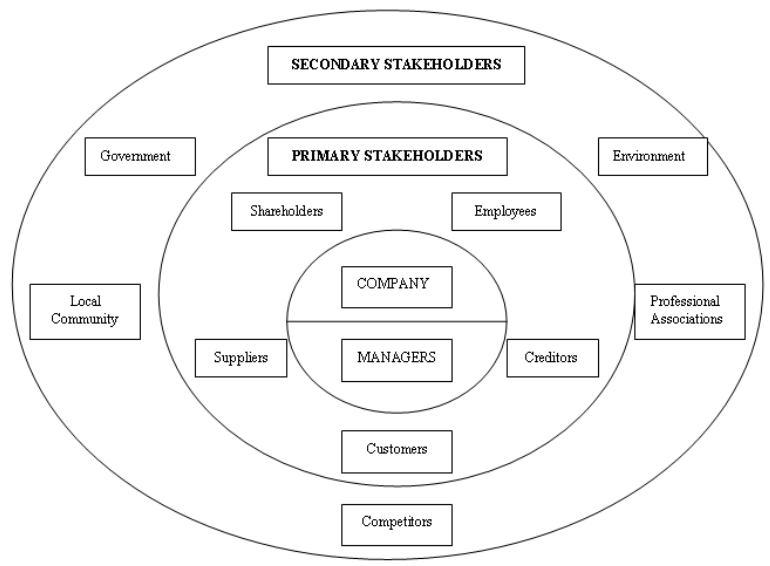
Figure 1: Primary and Secondary